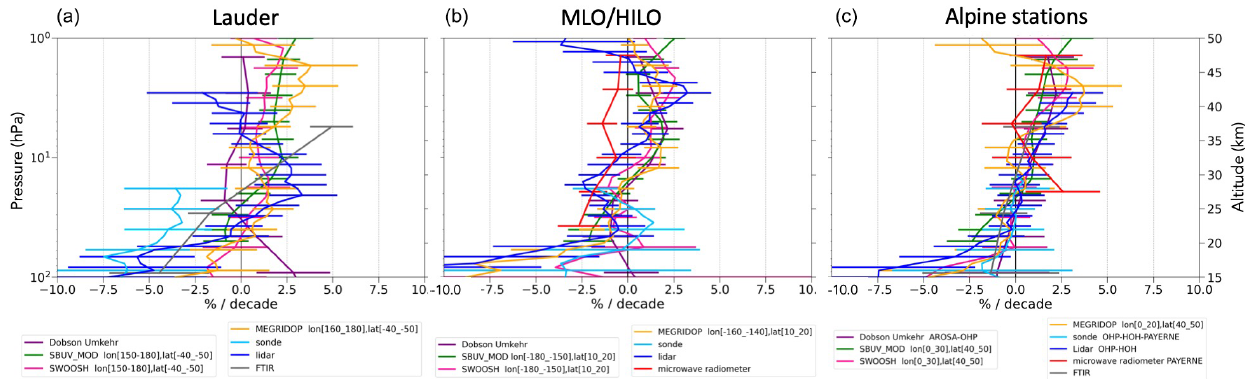
Figure 4. Ozone profile trends for the post-2000 periods from selected ground-based NDACC stations. (a) SH Lauder station, (b) tropical Mauna Loa and Hilo (ozonesondes) stations, (c) NH Alpine stations (see